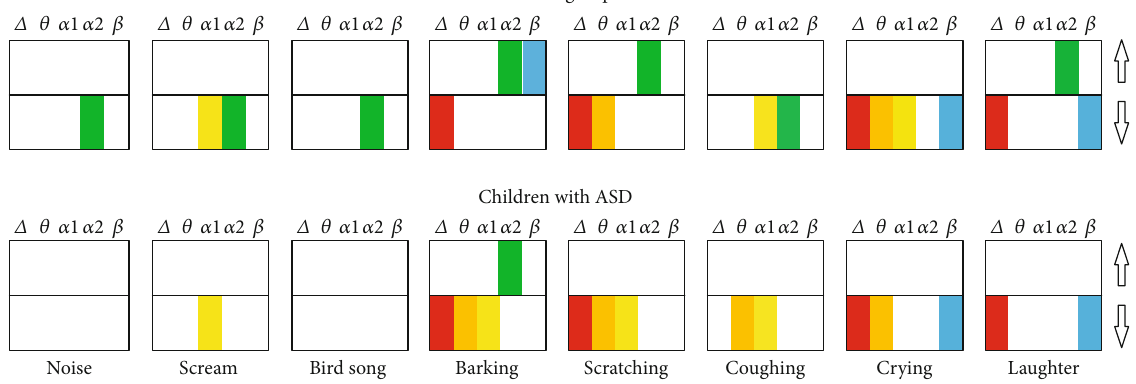
Figure 4: The PSD di ff erences between stimuli and rest for delta (2-4 Hz), theta (4-8Hz), alpha1 (8-10 Hz), alpha2 (10-12Hz), and beta (12-20Hz) bands. The colored columns depict signi fi cant di ff erences which were supported by the clustering permutation test and passed Bonferroni correction. Arrows (up and down) indicate an increase and decrease compared to the